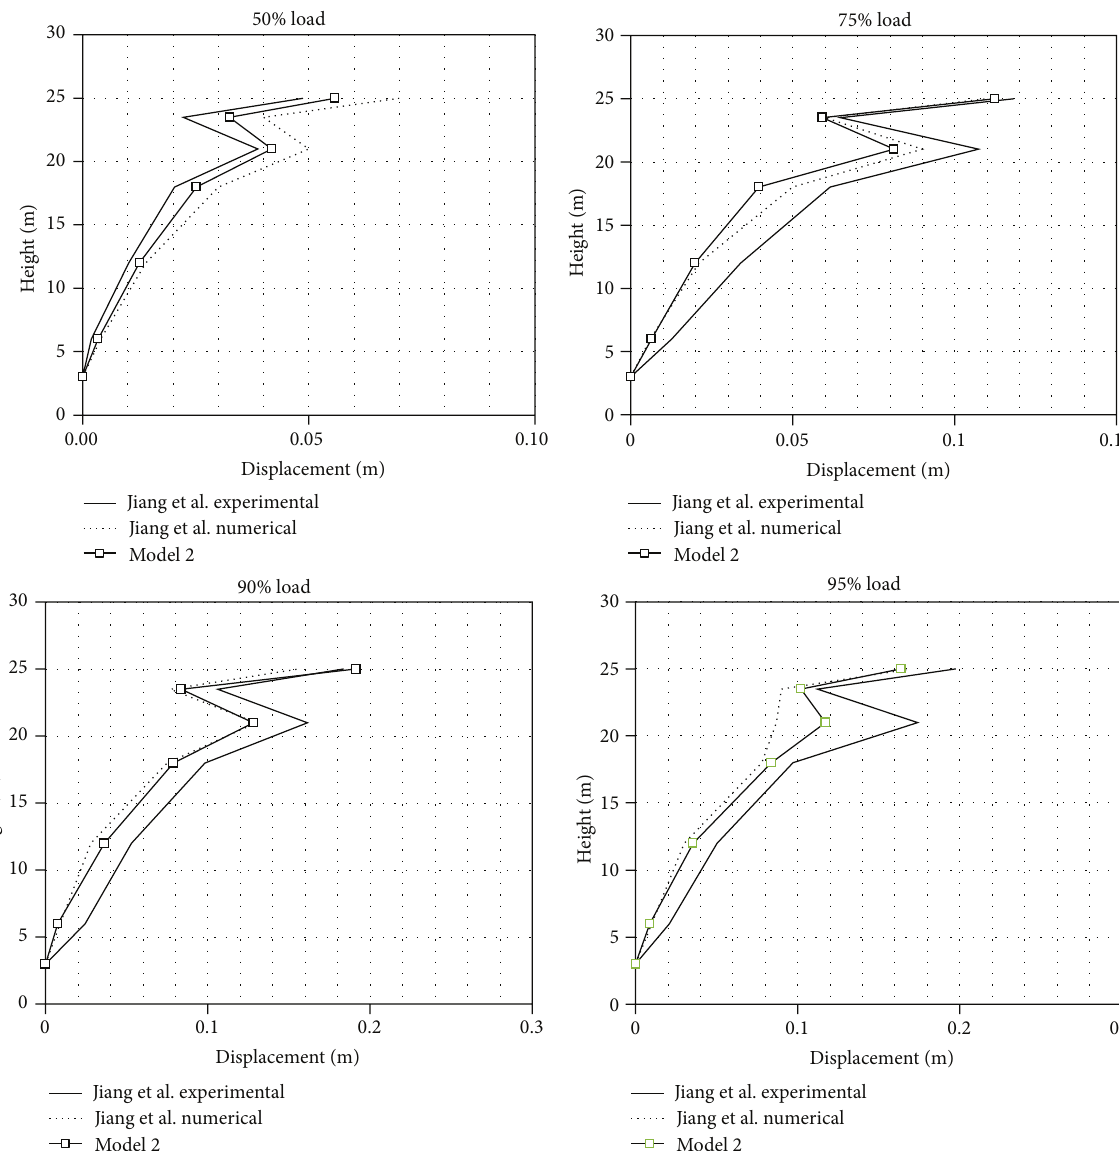
Figure 20: Tower 2 longitudinal displacement at normal construction